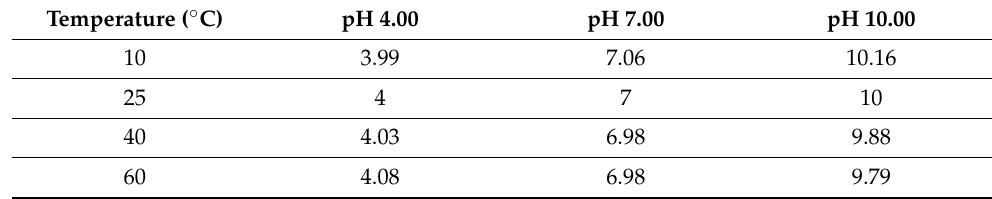
Figure 14. Characteristic curve offset graph. Table 1. The pH value of the standard solution at each temperature.